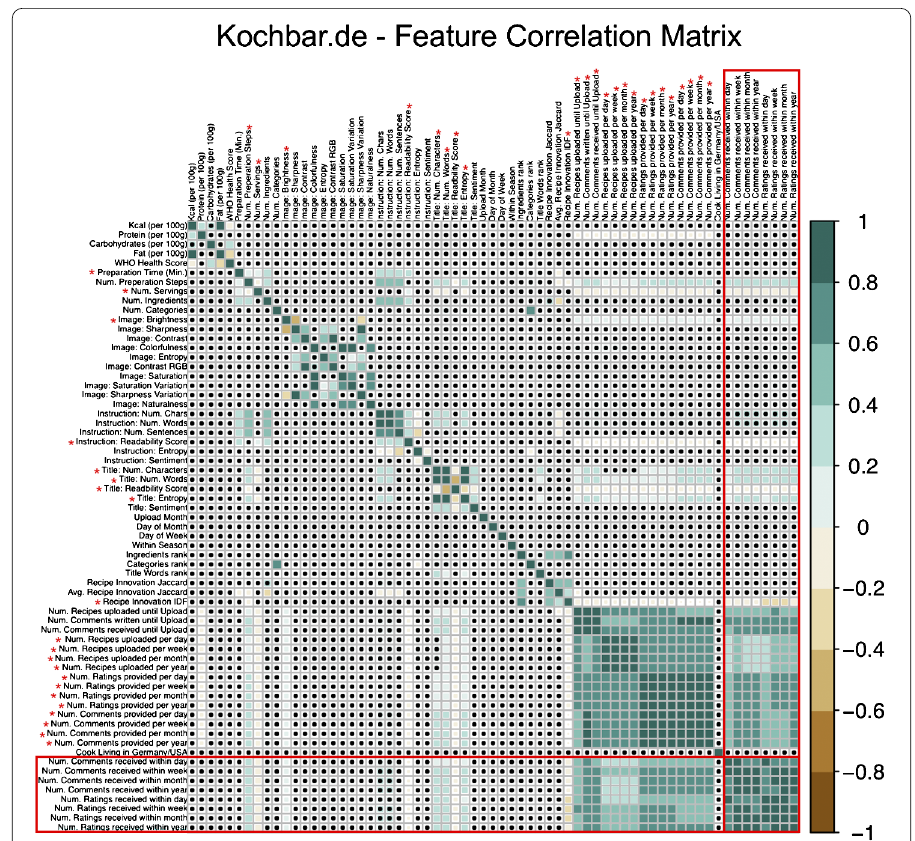
Figure 8 Feature correlation matrix (Spearman rank correlation) for the Kochbar.de dataset (main dishes). We mark non-significant features ( p < 0.05) with black dots. Features to be tested in the prediction experiment are highlighted via red boxes. Significant features marked with a red asterisk ( ∗ ). The gradient color scale to the right ranges from –1 to +1 indicate Spearman rank correlations (–1 = –100%, 1 =